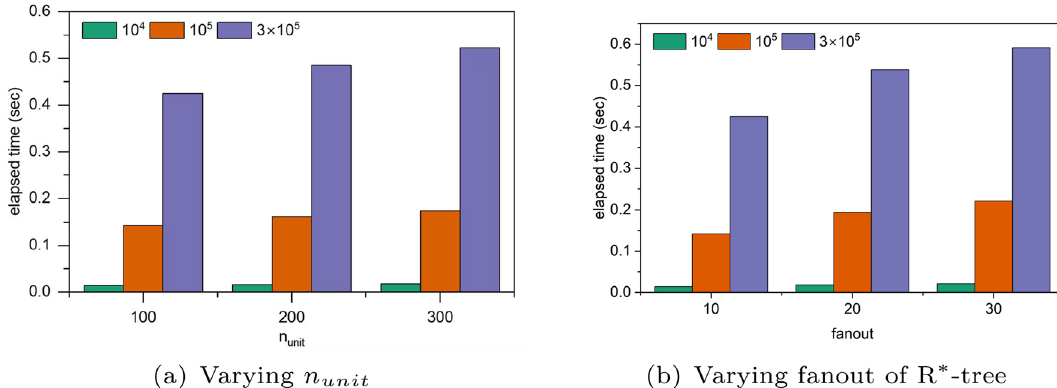
Fig. 14 Elapsed time of constructing trip index